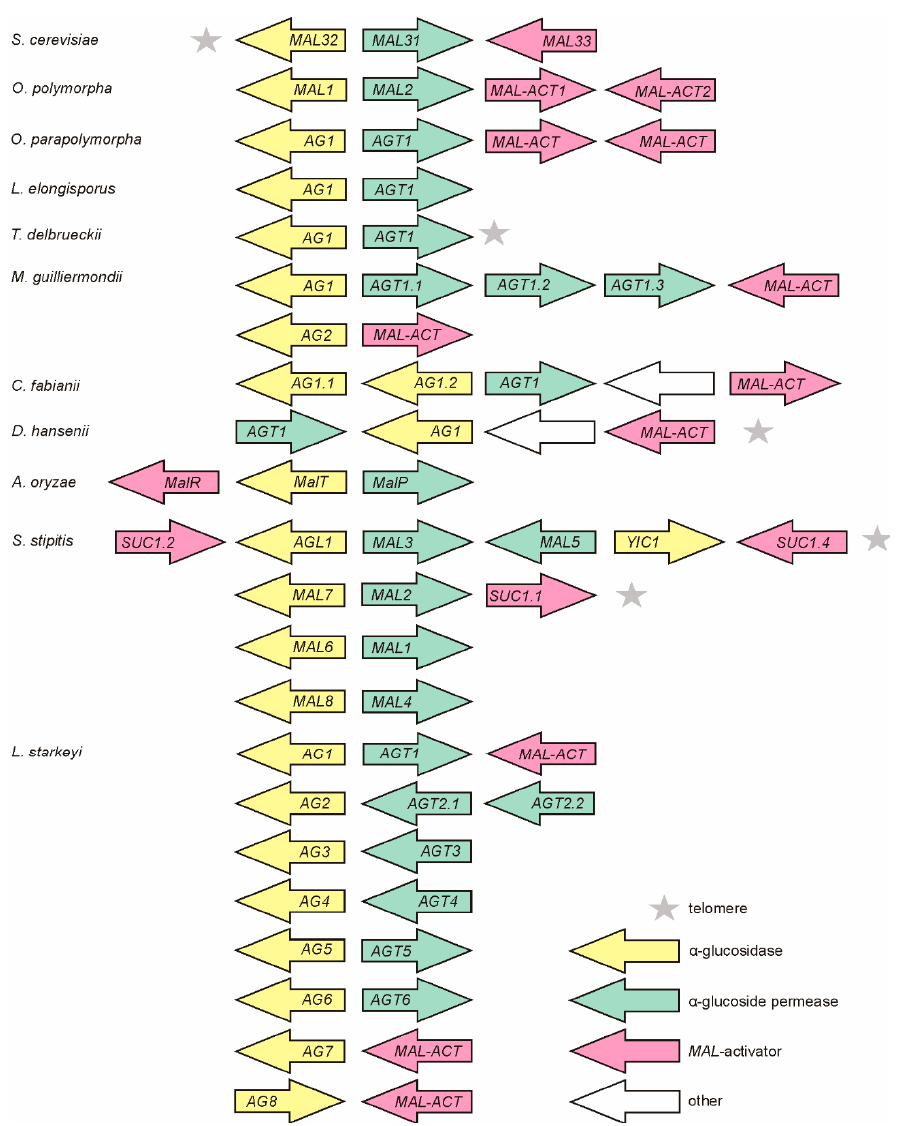
Figure 1. MAL loci and their composition in Ogataea polymorpha ( Op ) NCYC 495, Ogataea parapolymorpha ( Opp ) DL-1 and other non-conventional yeasts. Genes (potentially) encoding α -glucosidases (AG), α -glucoside transporters (AGT), and MAL -activators ( MAL -ACT) were retrieved from the genomic databases (see Table 1). The MAL clusters of Scheffersomyces stipitis [21], Aspergillus oryzae [50], and Saccharomyces cerevisiae ( MAL32 —maltase; MAL31 — α -glucoside permease; MAL33 — MAL -activator) are presented for comparison. Accession numbers and annotation data of the AG and AGT genes are given in Tables S1 and S2.